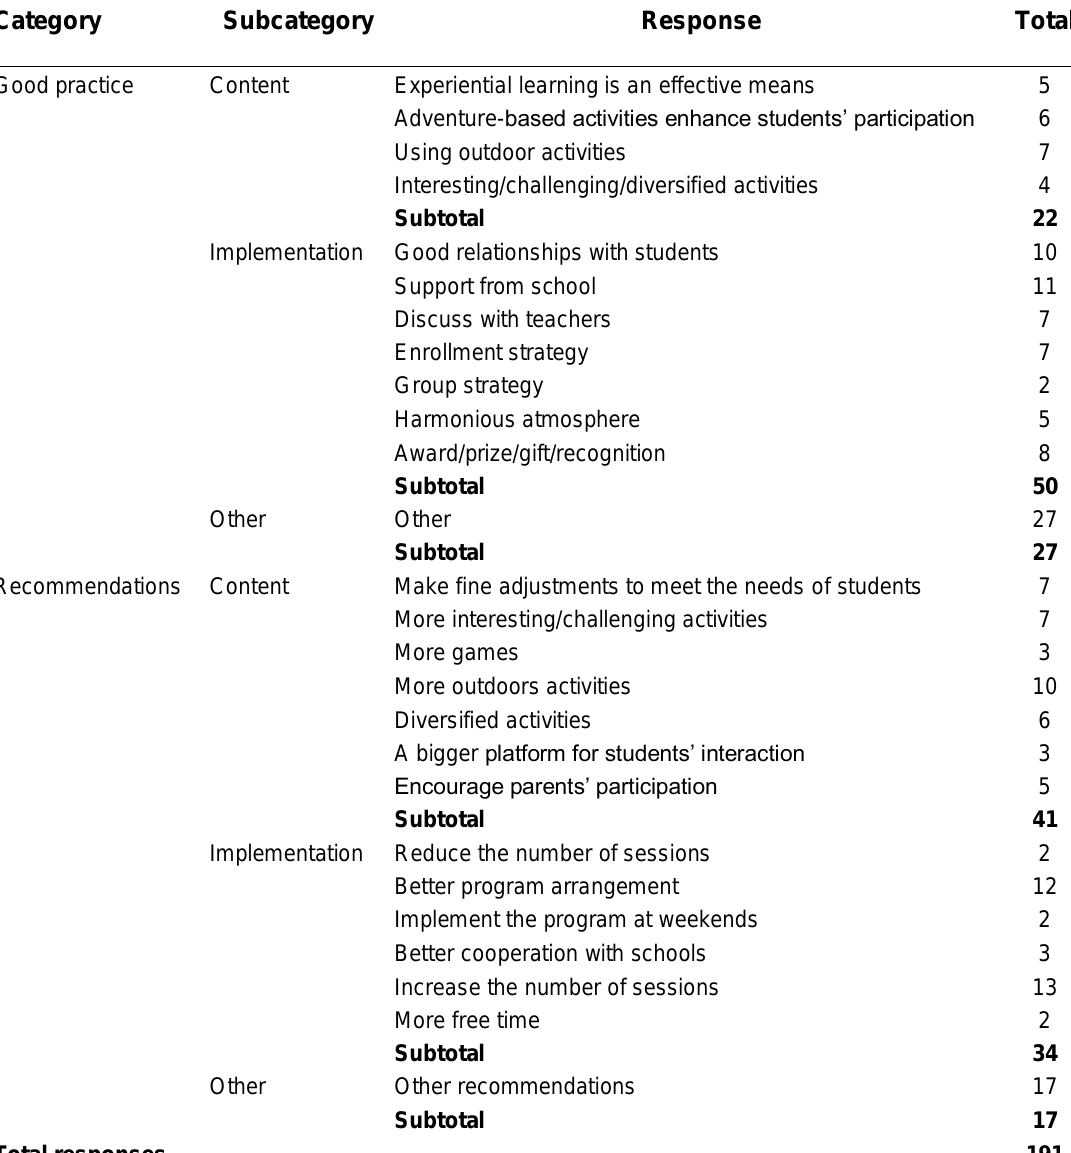
Responses to the Recommendations for the